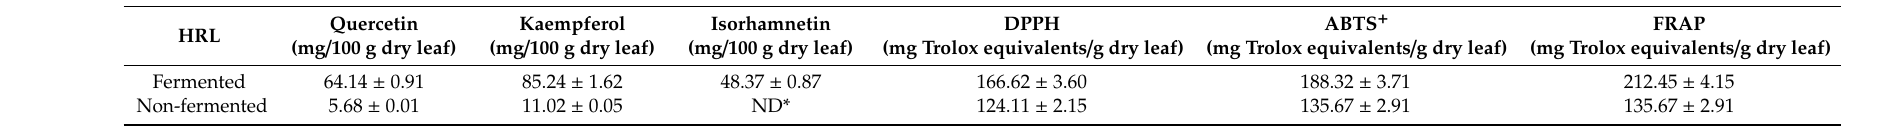
Table 1. Contents of aglycones and antioxidant activities of non-fermented and fermented HRL.